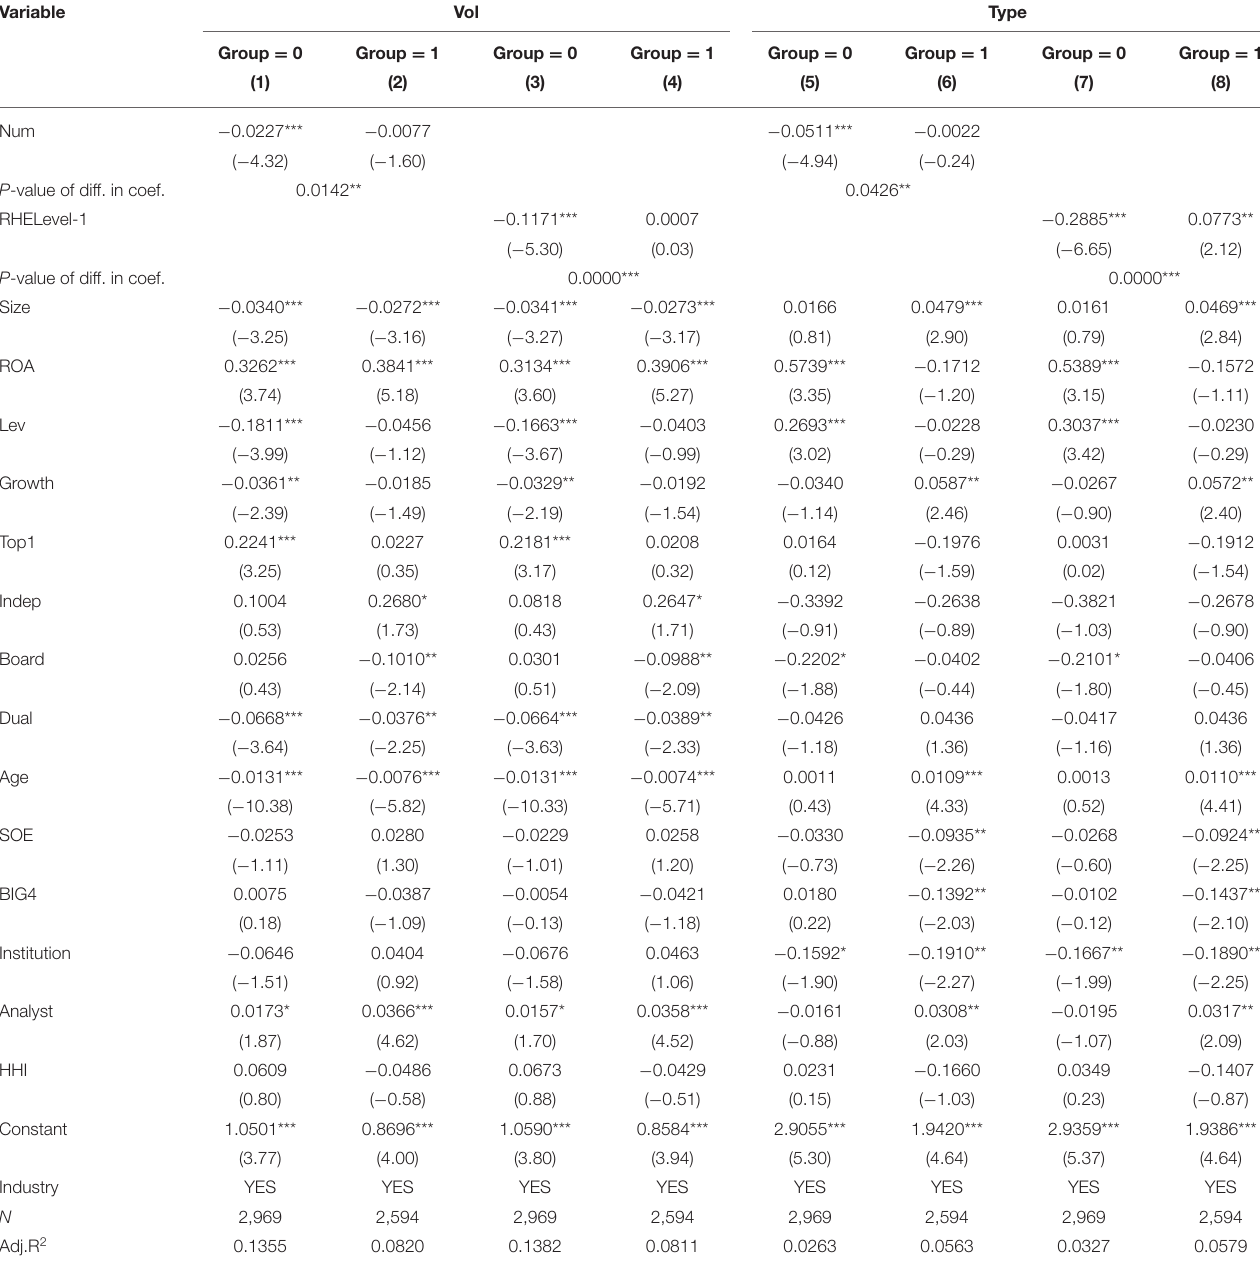
TABLE 17 | Impact of COVID-19 and Media Scrutiny on the management earnings